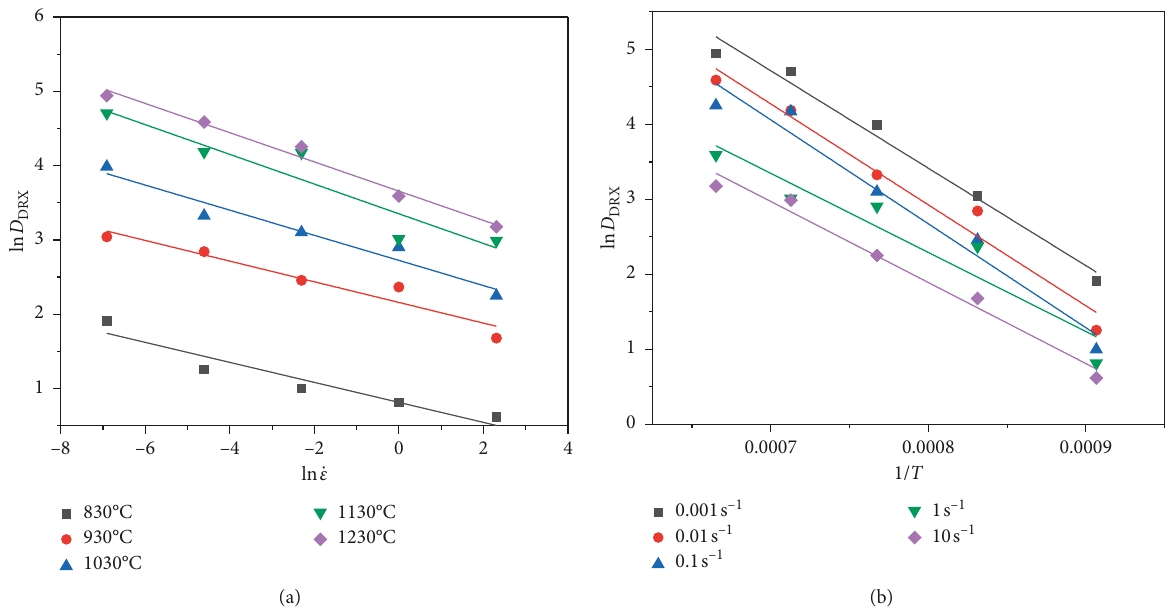
Figure 12: Relationships between (a) ln D